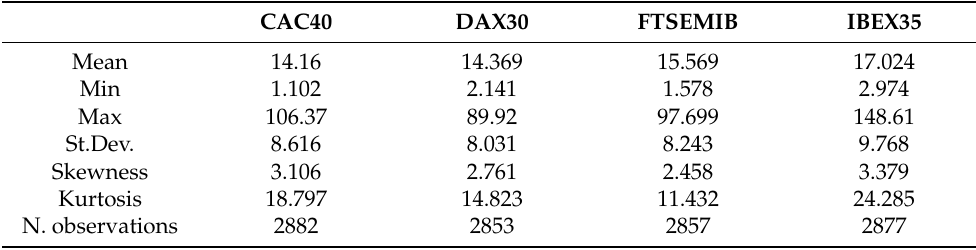
Table 1. Descriptive statistics for CAC40, DAX30, FTSEMIB, IBEX35 Realized Volatility.